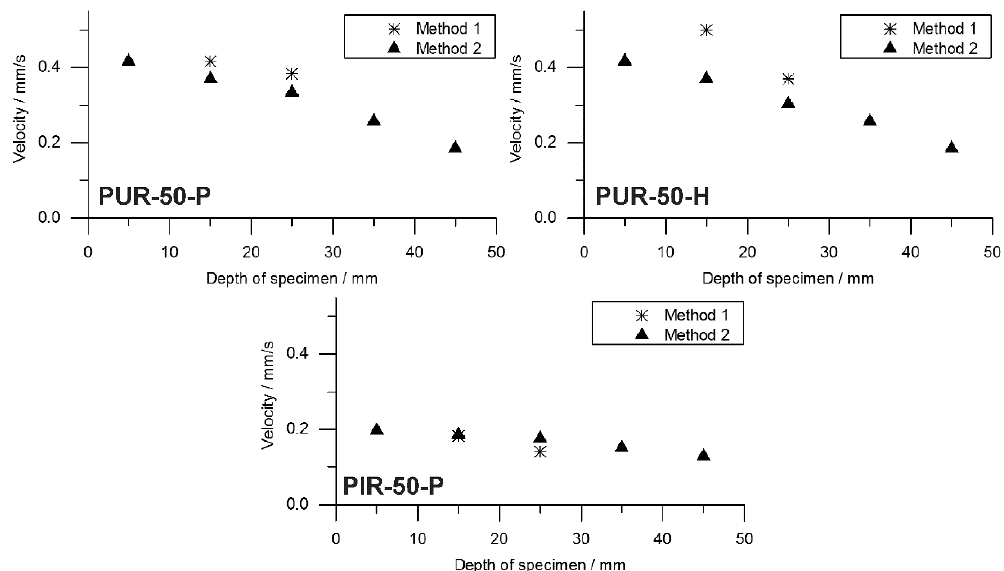
Figure 9. History of normalized sample weight for ( a ) PUR-P, ( b ) PUR-H and ( c ) PIR-P foams.